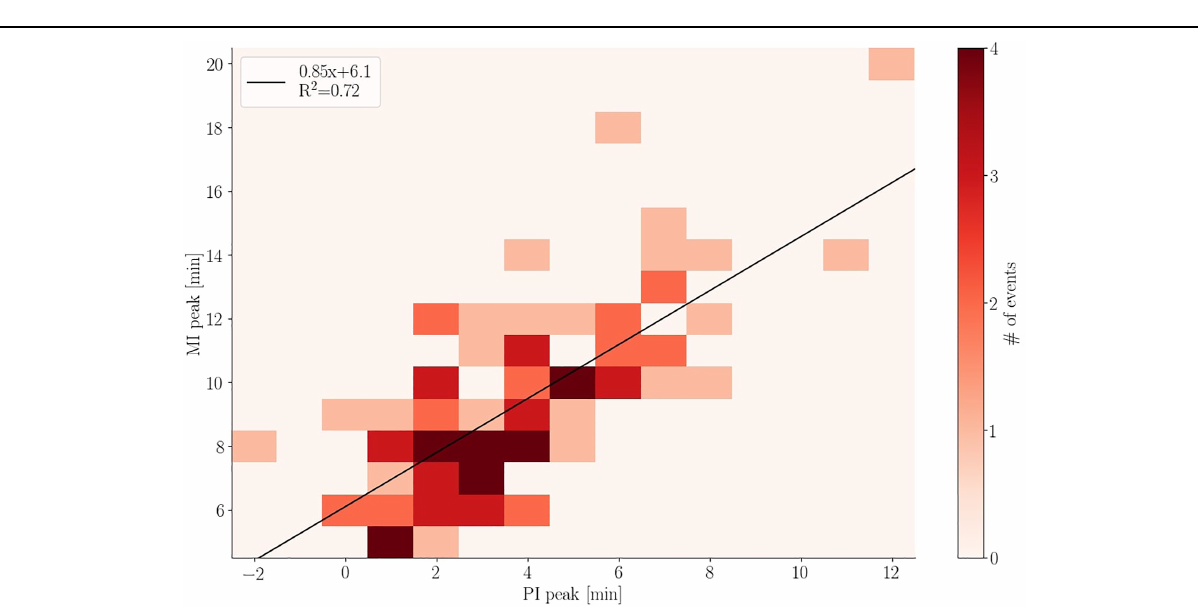
FIGURE 12 | Regression analysis of the DP PI and DP MI distribution in Figure 11